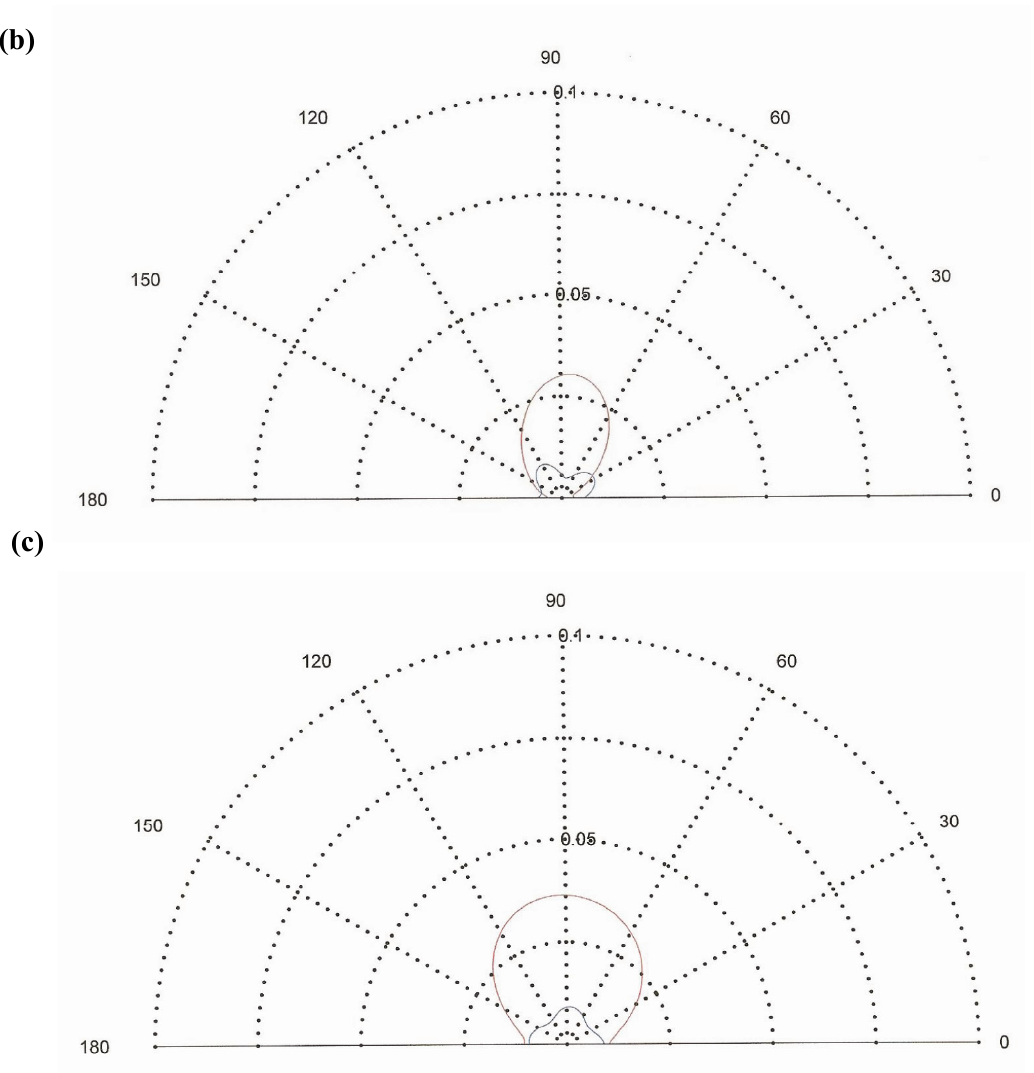
Figure 4 . Polar profiles of variance with ( a ) and without ( b ) two outliers for Subject 1 for the autokeratometer and ( c ) for the Pentacam. The radial coordinate has units D 2 . The scale was kept constant to accommodate the curves of graph 4( a ). Once the outliers were removed the variances for the autokeratometric samples decreased markedly. Figures 3( b ) and ( c ) indicate that the measurements were not very variable irrespective of instrument concerned. The red and blue lines are the curvital and torsional varances,